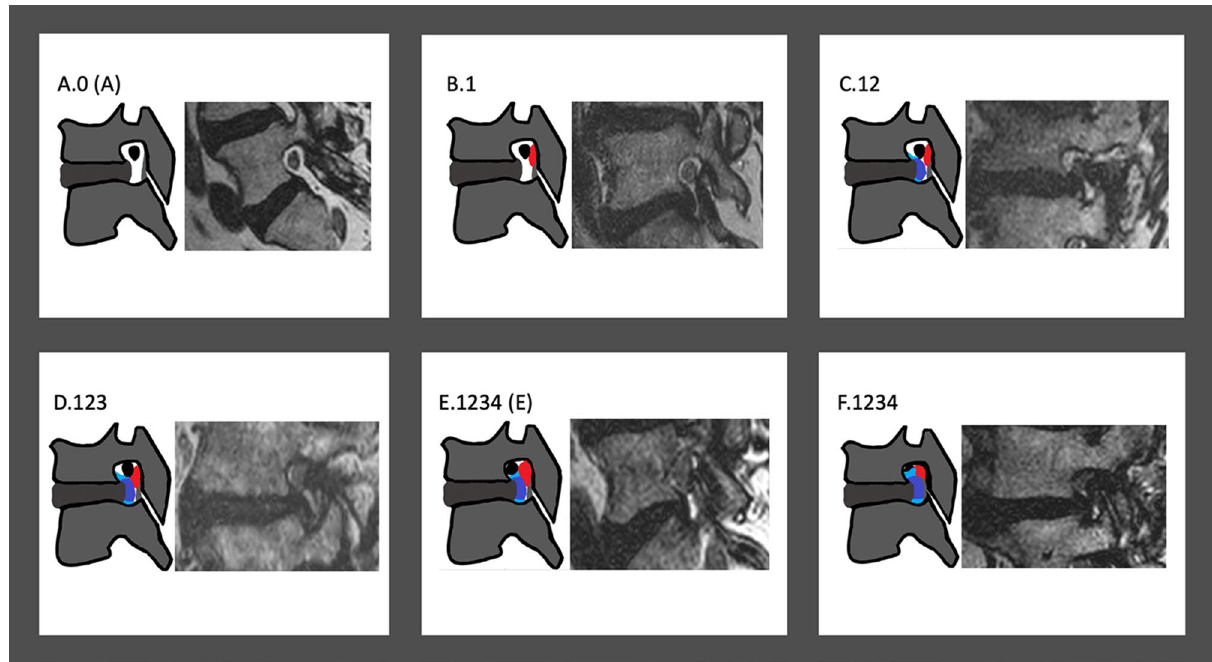
Figure 2. Schematic illustrations and imaging examples of relevant cases described in the updated grading